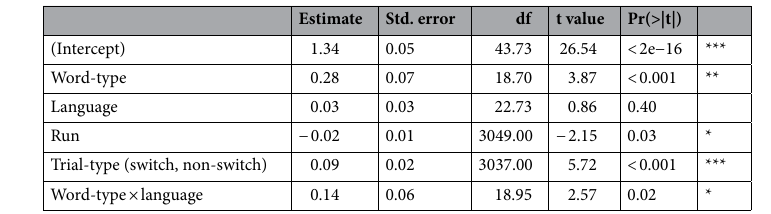
Table 3. Results from the linear mixed effect model predicting reaction time. Asterisks indicate main effects that reached significance.